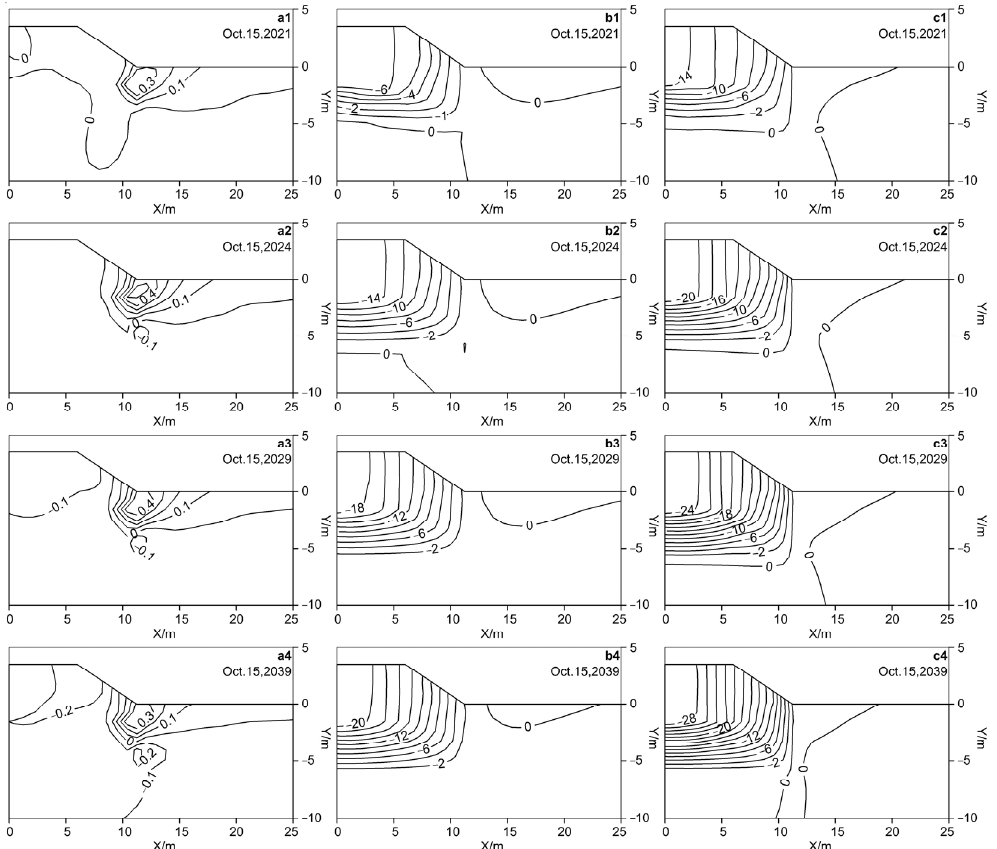
Figure 11. Vertical deformation contour maps of three subgrade structures in different years in warm seasons: ( a1 – a4 ) replacement block–stone subgrade structure, ( b1 – b4 ) the replacement breccia subgrade structure, and ( c1 – c4 ) the replacement gravel subgrade structure. (Unit: cm). Generally, the influence of vertical deformation on subgrade stability is often of